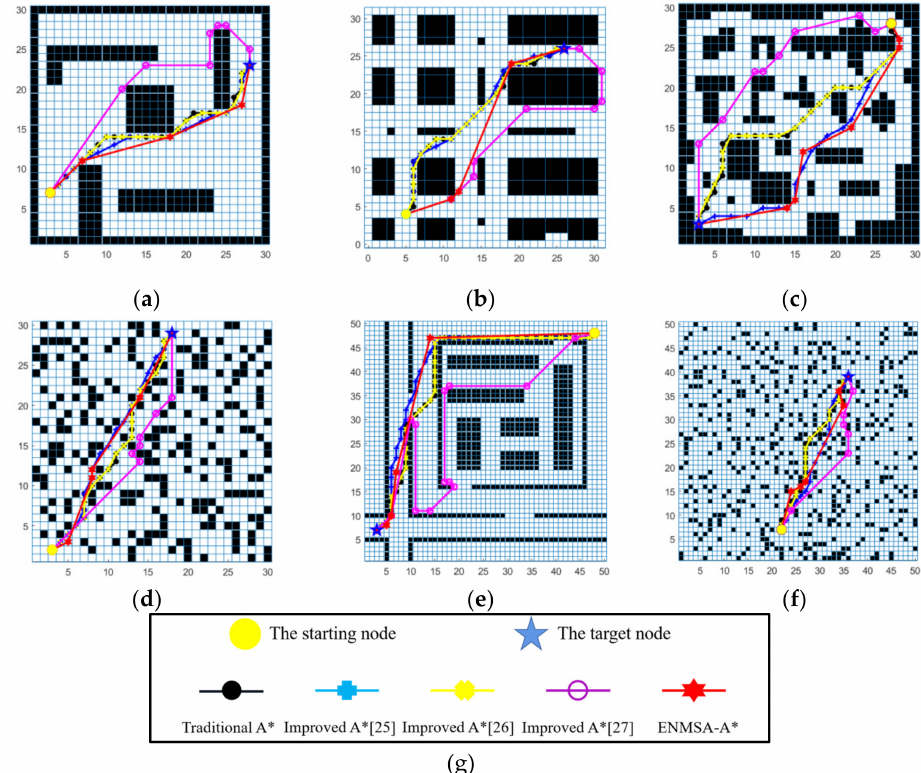
Figure 12. Demonstration of improved algorithm path planning for different map environments: ( a ) Simple Map 1; ( b ) Simple Map 2; ( c ) Complex map; ( d ) 30 × 30 random map; ( e ) 50 × 50 extended map; ( f ) 50 × 50 random map; ( g ) the shapes and various color curves in this figure refer to the